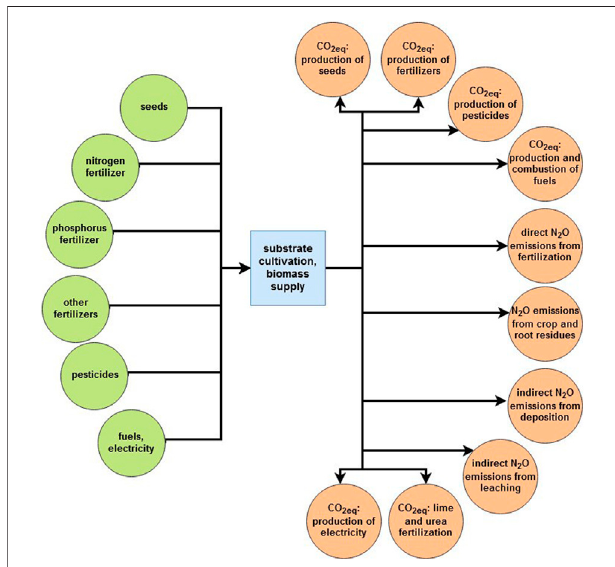
FIGURE 3 | Emission sources of substrate cultivation and biomass